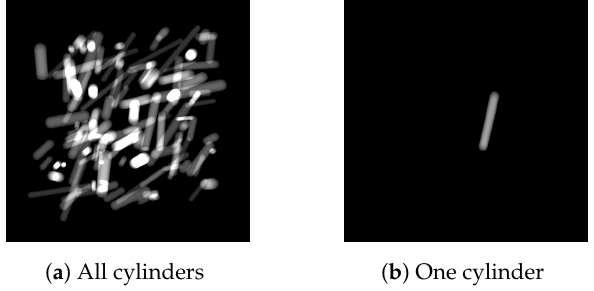
Figure 6. Schematic overview of the hyperspectral X-ray projection setup with a cone beam geometry.